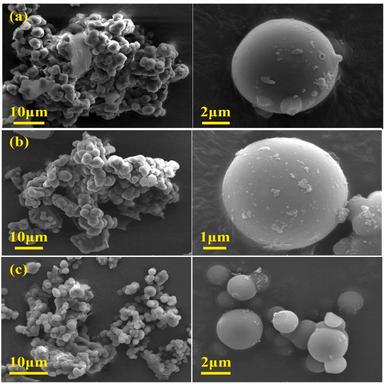
SEM images of (a) MicroEPCM-2%SiC; (b) MicroEPCM-4%SiC; (c) MicroEPCM-6%SiC.